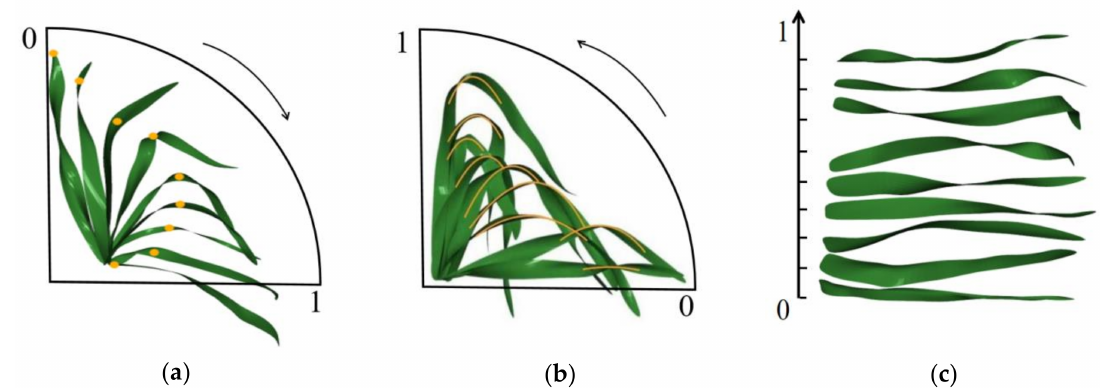
Figure 8. Leaf sequencing results of leaf sag ( a ), bending ( b ), and twisting ( c